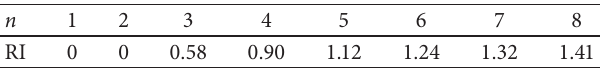
Table 2: The parameters of the random consistency index